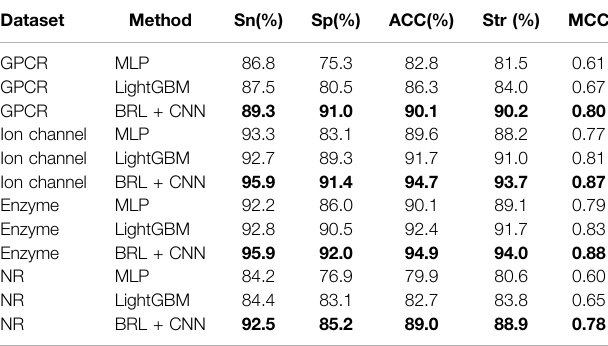
TABLE 1 | Results of comparison with several traditional machine learning methods on four datasets. Dataset